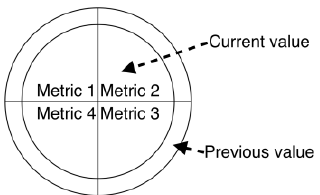
Figure 22. An example of a glyph with four kinds of parameters. The inner part of the glyph displays the current values, while the outer part shows the previous ones.